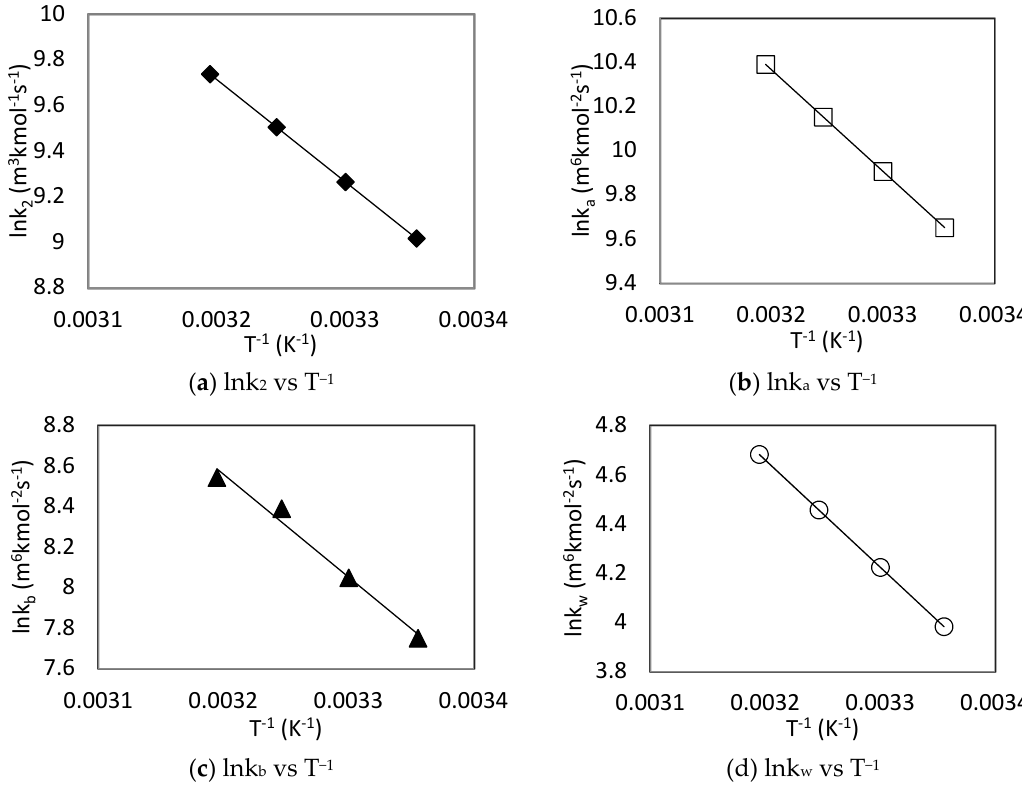
Figure 8. Parity plot of experimental and predicted k Arg values for Zwitterion mechanism.